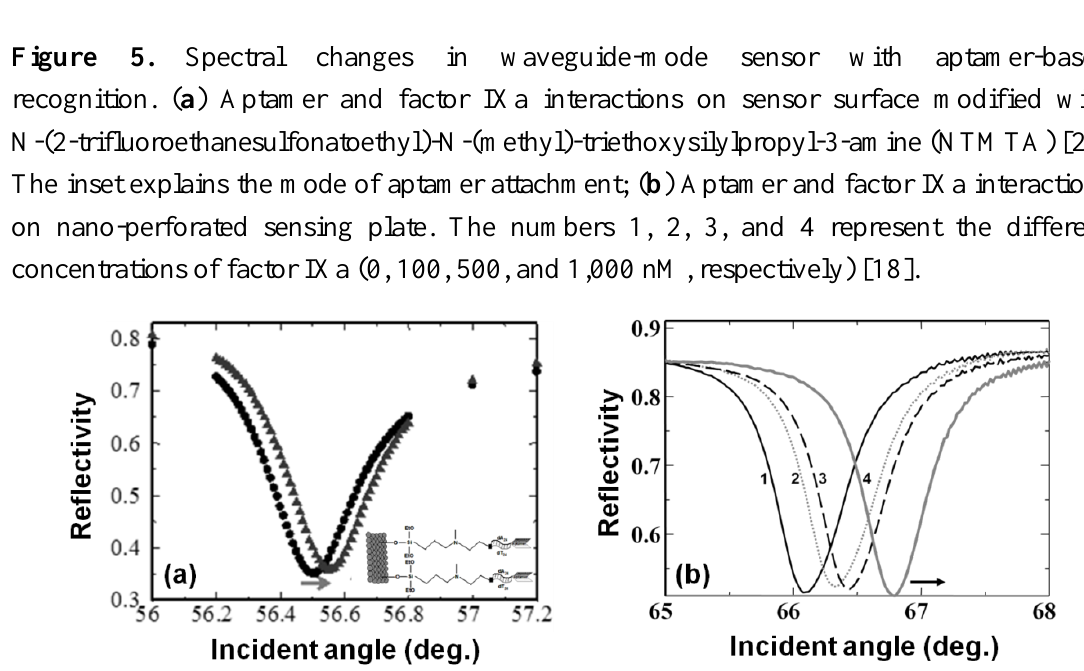
Figure 5. Spectral changes in waveguide-mode sensor with aptamer-based recognition. ( a ) Aptamer and factor IXa interactions on sensor surface modified with N-(2-trifluoroethanesulfonatoethyl)-N-(methyl)-triethoxysilylpropyl-3-amine (NTMTA)